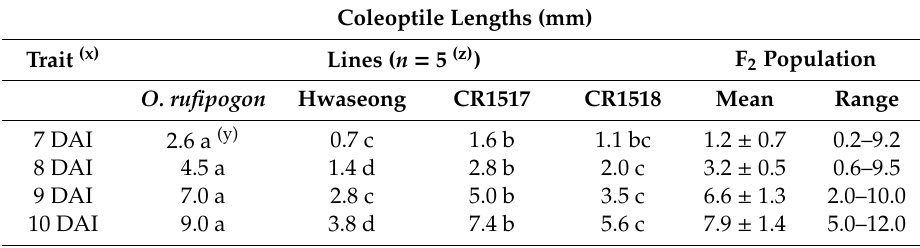
Table 3. Mean coleoptile lengths (mm) in O. rufipogon , Hwaseong, two introgression lines, and F 2